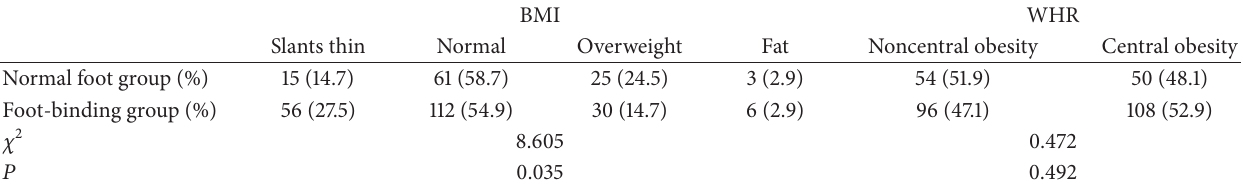
Table 2: Bodily form contrast of normal foot group ( 𝑛 = 104 ) and foot-binding group ( 𝑛 = 204 ).